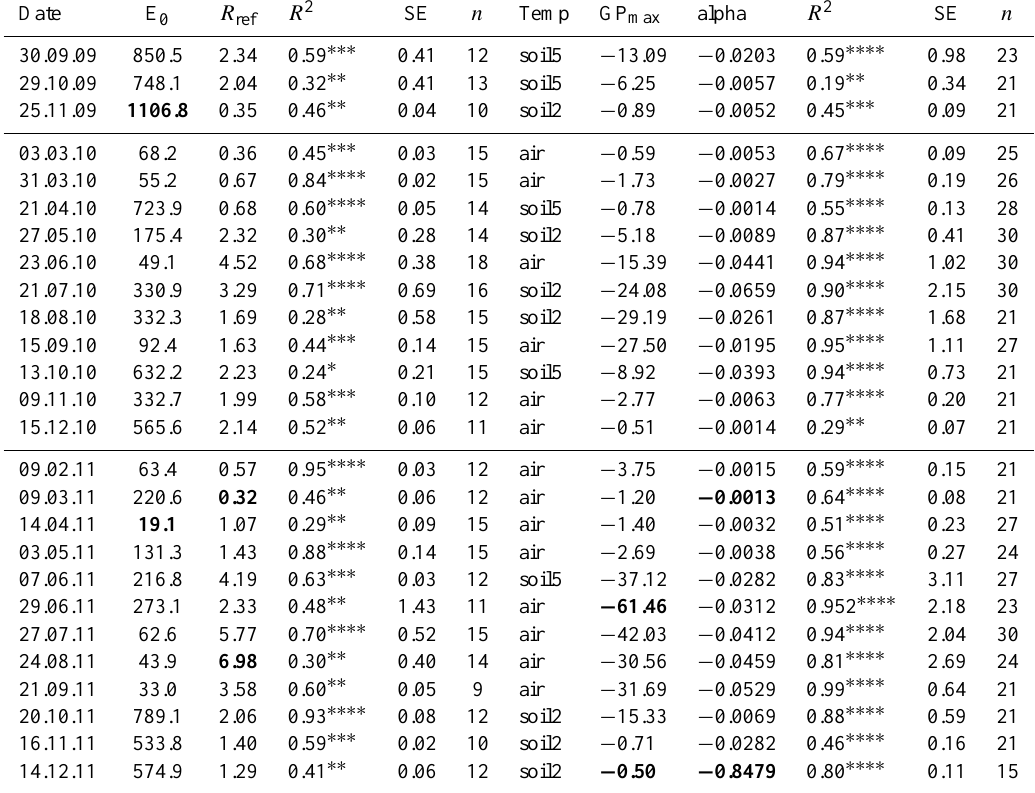
Table 3. Parameters for the R eco and NEE models of “ Molinia ”; E 0 : activation energy like parameter (K); R ref : respiration at the reference temperature (µmolCO 2 -Cm − 2 s − 1 ); temp: best fit temperature for R eco model. GP max : maximum rate of carbon fixation at PAR infinite (µmolCO 2 -Cm − 2 s − 1 ); alpha: light use efficiency (µmolCO 2 -Cm − 2 s − 1 /µmolm − 2 s − 1 ); R 2 : coefficient of determination (Pearson) be- tween modelled and measured values. SE: standard error of the model (µmolCO 2 -Cm − 2 s − 1 ); n : number of samples. Max. and min. values are printed in bold. Eventually measurement campaigns were pooled